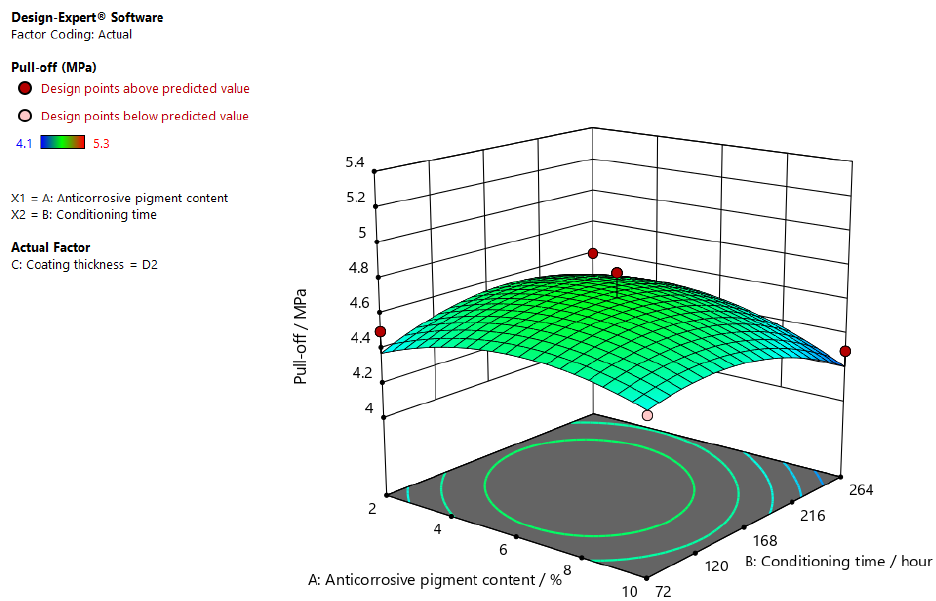
Figure 4. Response surface for regression model of the dependence of adhesion force (pull-off) between the applied coating and the substrate surface for the D2 coating thickness.